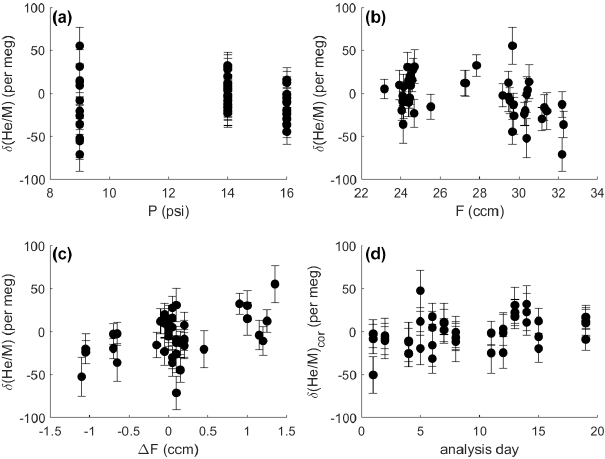
Figure 7. Difference in δ (He / M) between two identical gas streams (i.e., the zero enrichment) measured repeatedly under different con- ditions over 1.5–3h. Error bars show 1 σ uncertainty (internal preci- sion). Measurements were made at different pressure levels (a) , with slightly varying gas flows to the stabilization chamber (b) and im- balances in flow between the SA and ST side (c) . The same shared capillary was used for all analysis. Therefore, the pressure in the stabilization chamber controls the intensity of the ion beam and the internal precision of the analysis, illustrated by the greater scatter of observations at 9psi (62.1kPa). Delta values shown in panel (d) were corrected for the influence of pressure, mean flow and flow imbalance according to coefficients found by multiple linear regres- sion (see text). For a pressure of 14psi (96.5kPa), corrected delta values generally show scatter as expected from shot-noise behavior, and corrected delta values are stable over